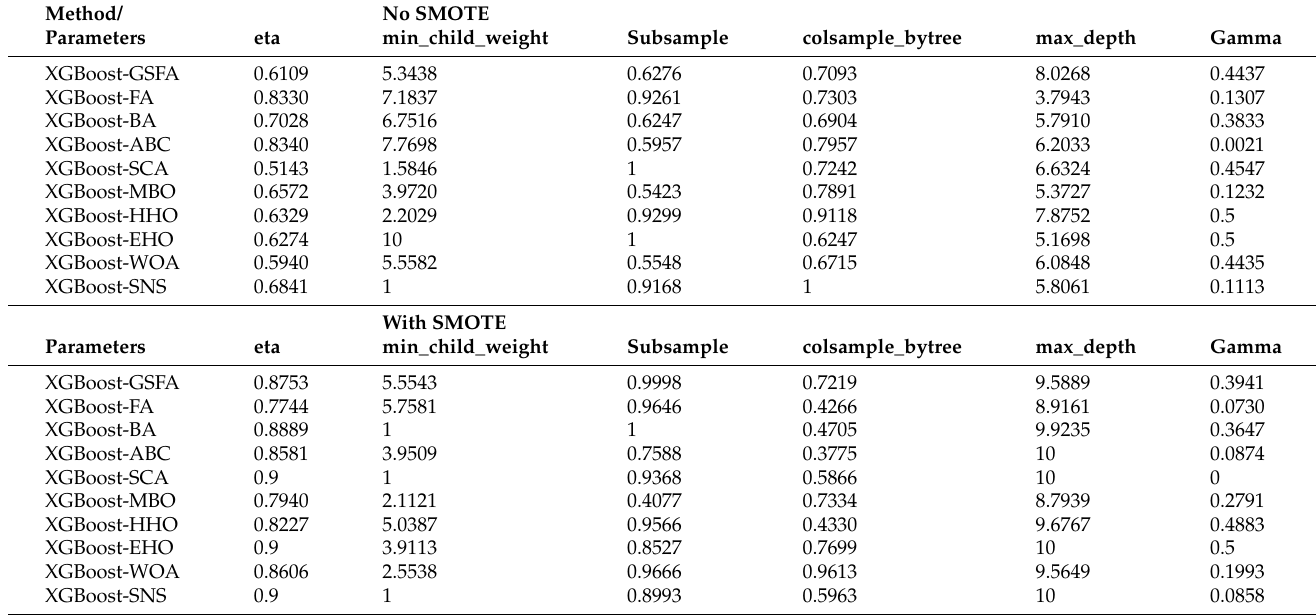
Table 16. Best XGBoost parameters’ values obtained by the analyzed